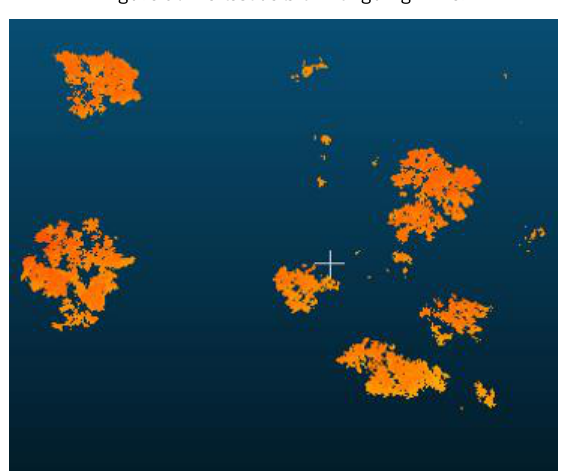
Figure 9.The test data of Yongding River